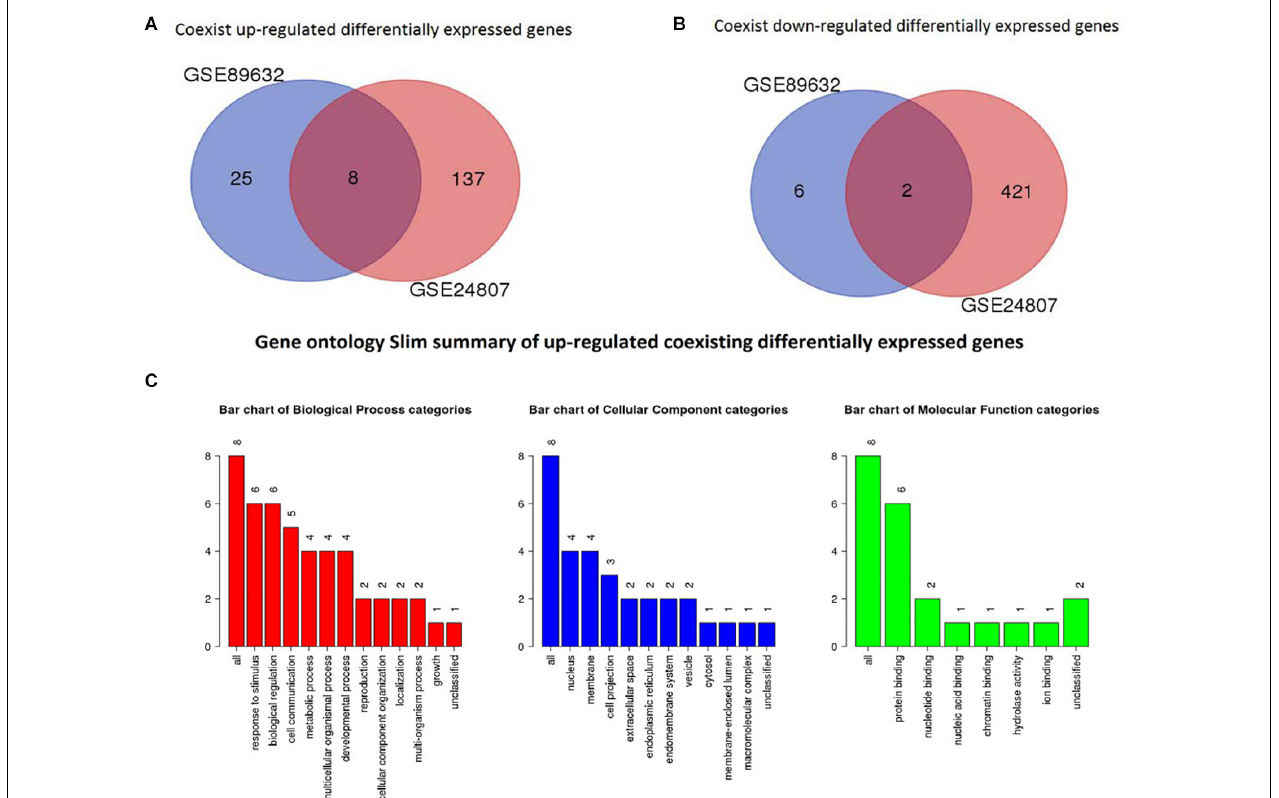
FIGURE 4 | Identification of coexisting DEGs. (A) Shows Veen diagram of up-regulated DEGs. (B) Displays Veen diagram of down-regulated DEGs. (C) Shows gene ontology Slim summary of up-regulated coexisting DEGs.